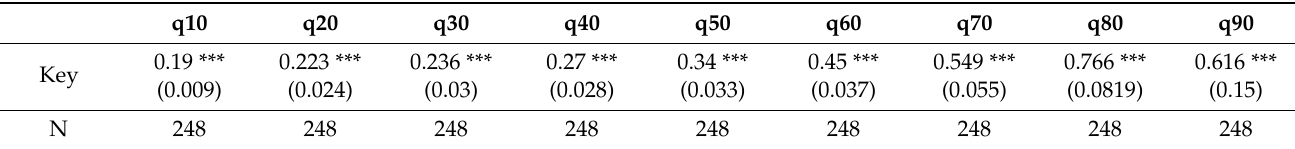
Table 5. Results of quantile DID